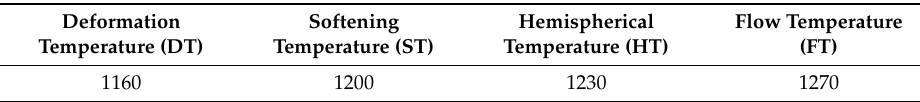
Table 3. Coal ash fusibility ( ˝ C).